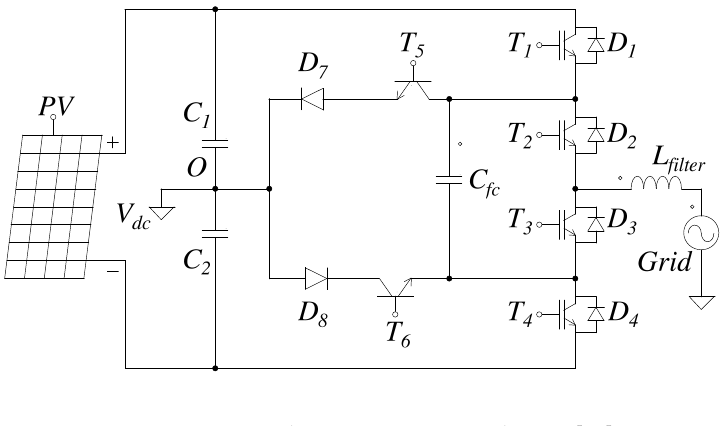
Figure 8. Proposed ANPC inverter topology in [75]. Table 7. Operation modes of the proposed topology in